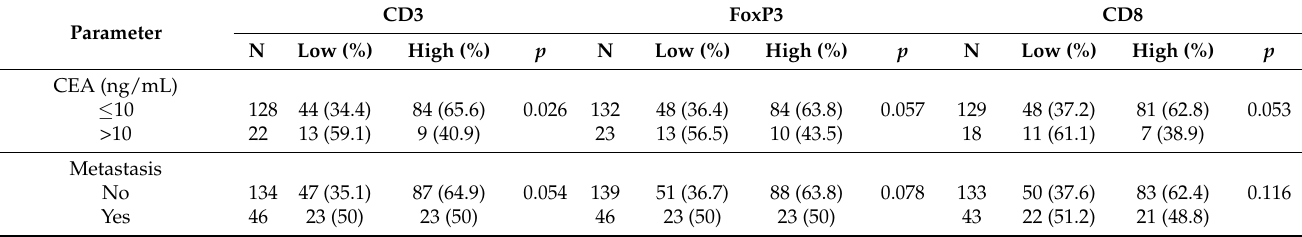
tumor margins are associated with good prognostic indicators. Table 7. Association of tumor margin infiltration of CD3 + , FoxP3 + , and CD8 + T lymphocytes with pathological data.